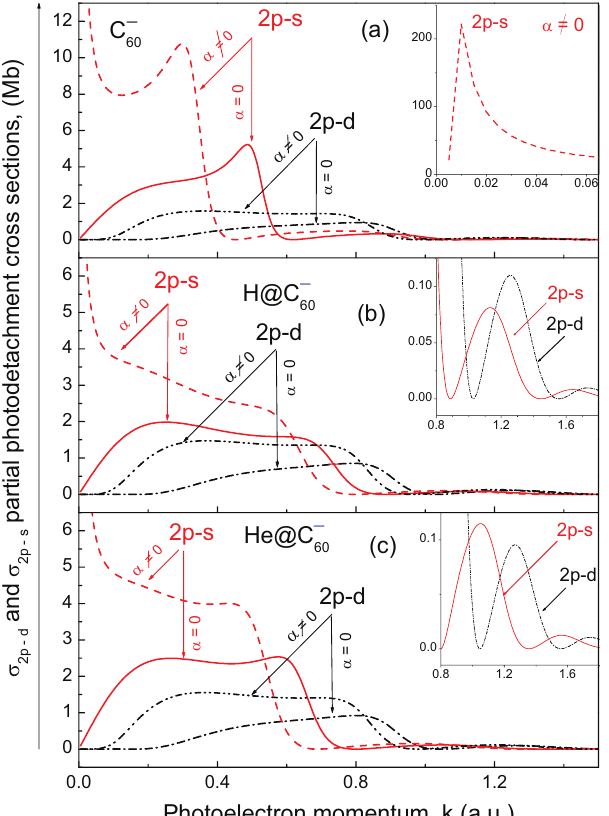
( 2 p ) , ( b ) H@C − ( 2 p ) and 60 60